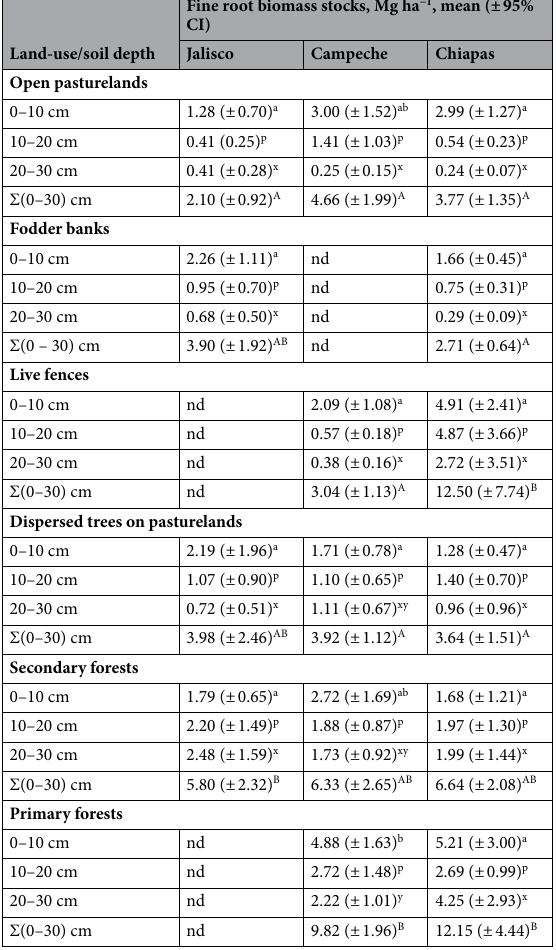
Table 4. Fine root biomass (Mg ha −1 ) in the soils across different land-uses by depth classes and region. Different letters indicate statistical differences between land-uses (p < 0.05) within the same depth class. CI = Confidence intervals. nd: data not